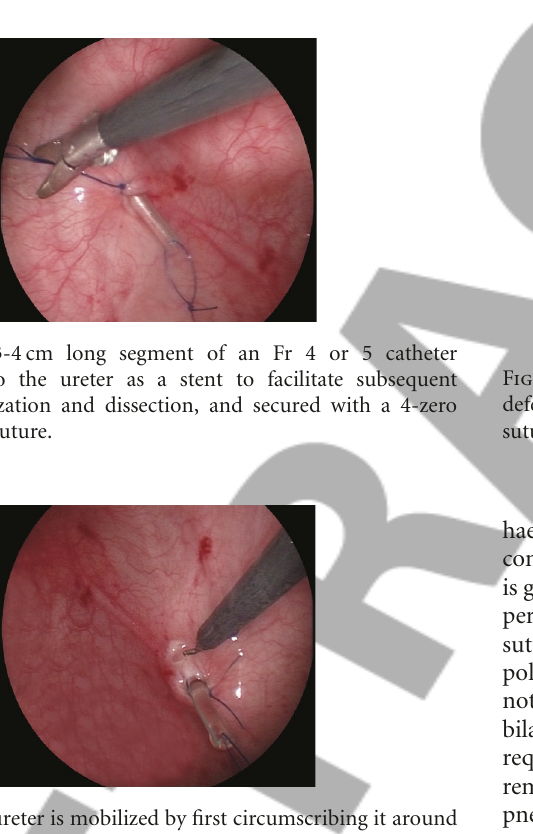
Figure 1: 5-mm working ports inserted along the interspinous skin crease on either side of the lower lateral wall of the distended bladder under vesicoscopic guidance.